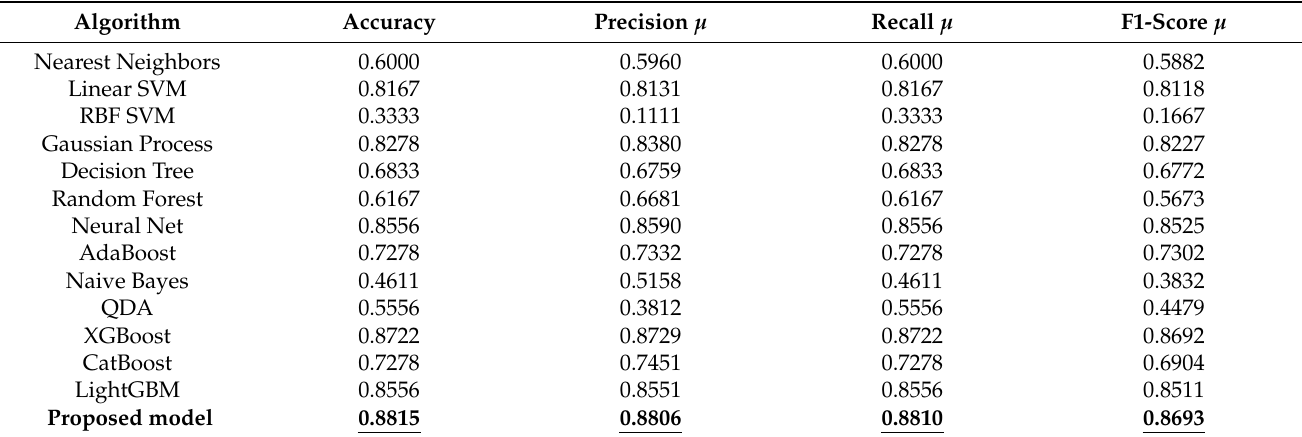
Table 8. Age classification of Koshihikari rice seeds.